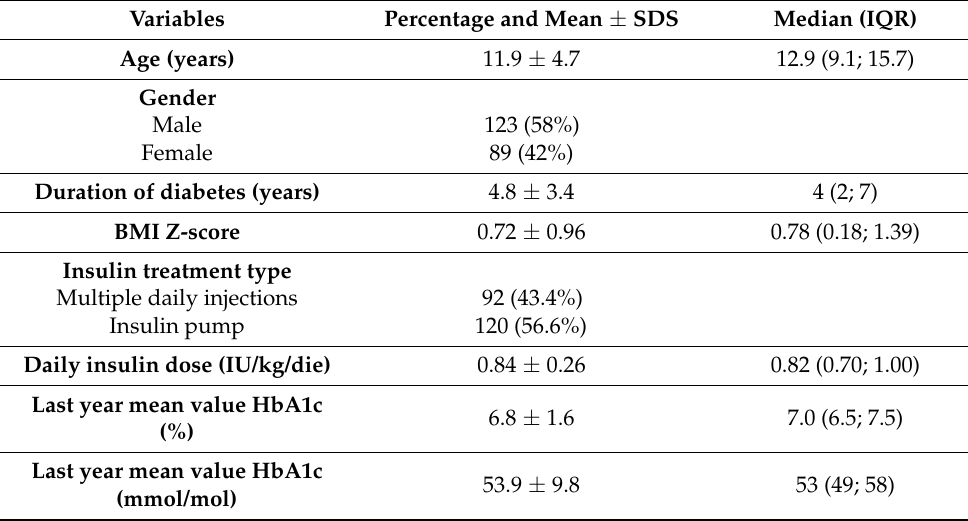
Table 1. Descriptive statistics for categorical (percentages) and numerical (mean ± SDS and interquar- tile ranges) variables of the 212 patients included in